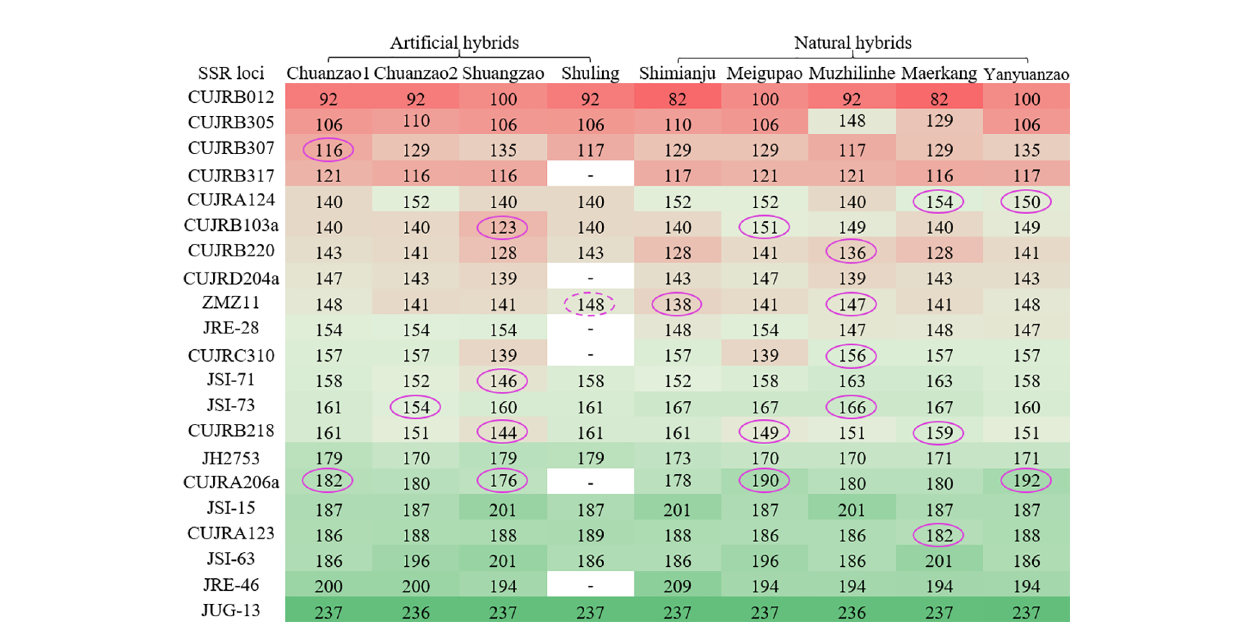
FIGURE 7 | Allele sizes of 21 SSR loci of the four arti fi cial hybrid cultivars and fi ve natural hybrid cultivars. The SSR loci were aligned based on the allele size of the Chuanzao 1 cultivar from smallest to largest. Color gradients of red, blue, and green were used to mark all the allele sizes in Excel 2019. Red represents small allele sizes, green represents large allele sizes, and light blue represents intermediate allele sizes. Six SSR loci of the Shuling cultivar were not obtained, as shown by “ - ” in the column for this cultivar. The allele sizes in purple ovals are those that can be used to discern the cultivars (except for allele size 148 in the dashed oval, because Shuling can be discerned by the combination of ZMZ11 (148) and other SSR loci, which distinguish and exclude Chuanzao 1 and